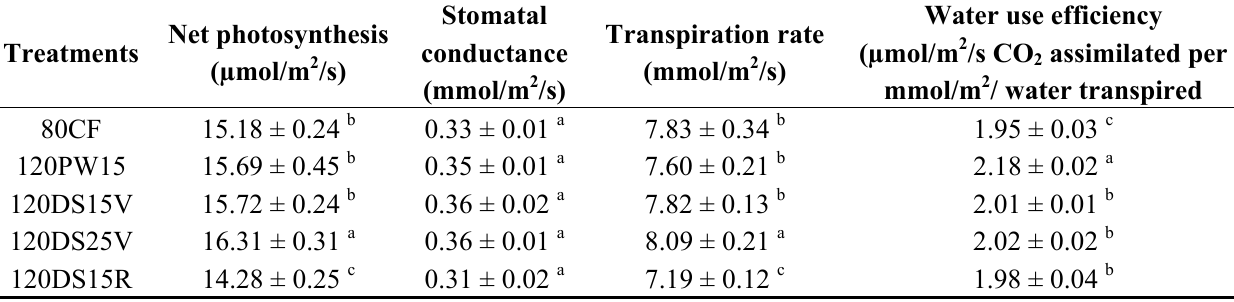
Table 6. Impact of potassium fertilization on the leaf gas exchange under water stress at different growth stages of rice. Data are means ± standard error of differences between means (SEM). N = 12. Means not sharing a common single letter were significantly different at p ≤ 0.05.